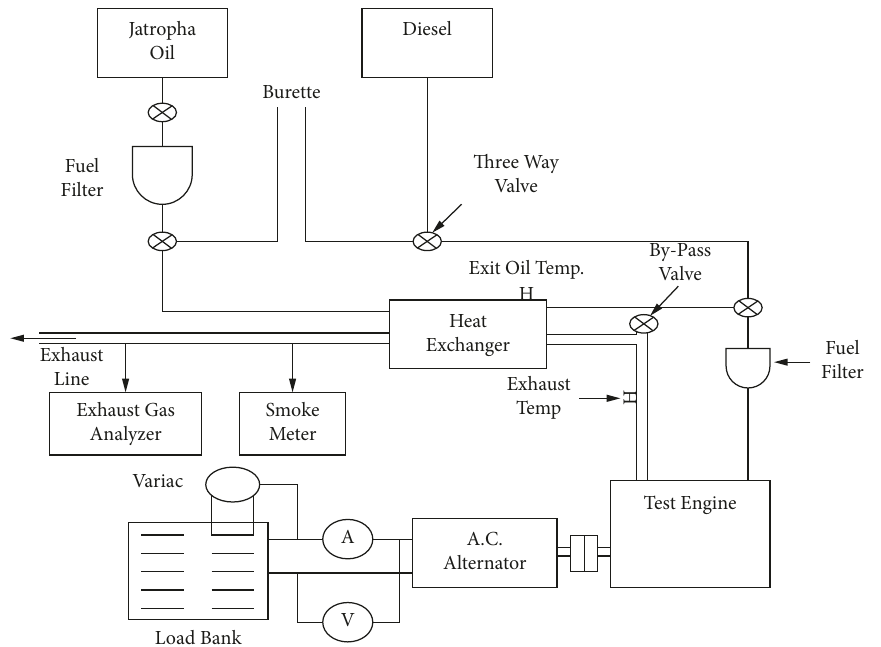
Figure 6: Schematic diagram and the experiment setup [24].